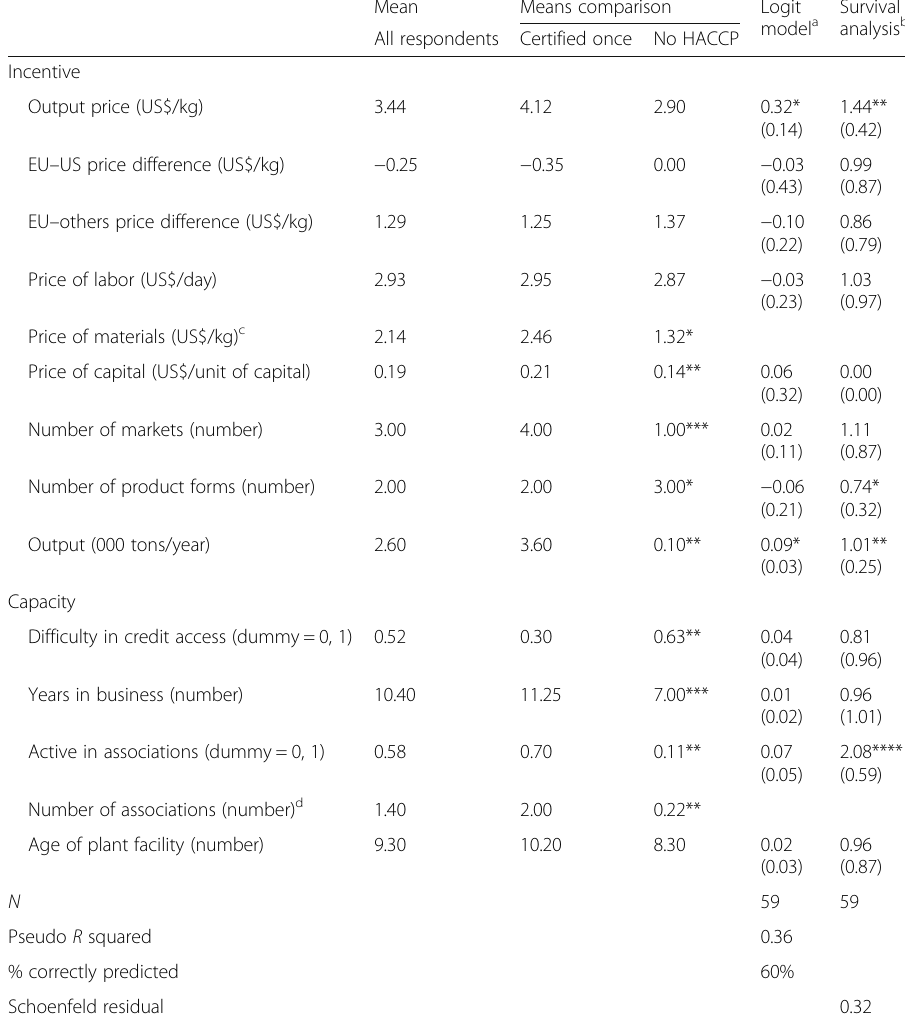
Table 4 Results of the means comparison, logit, and survival analyses to explain initial adoption